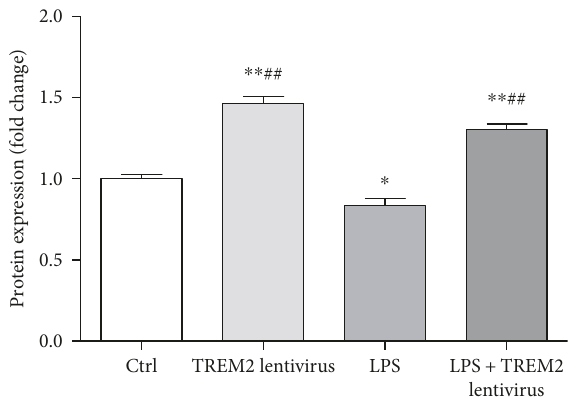
Figure 2: LPS decreases TREM2 expression and TREM2 lentivirus increases TREM2 expression in microglia. Primary microglia were treated with LPS (100ng/mL) for 12h. Cell lysates were analyzed by Western blotting. Microglia treated with LPS showed decrease in TREM2 levels. Overexpression of TREM2 showed a marked increase in TREM2 levels compared with LPS alone ( ∗ P < 0 05 , ∗∗ P < 0 01 versus control group; ## P < 0 01 versus LPS